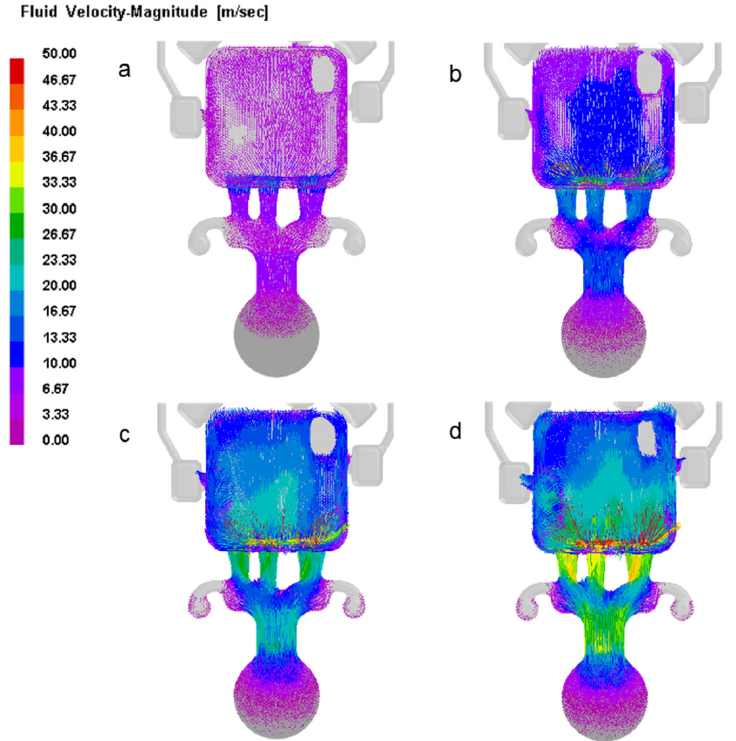
Figure 7. Simulation results of a fluid vector at the ingate and the cavity during the fast stage of piston velocity: ( a ) piston velocity was 0.8 m/s, ( b ) piston velocity was 1.6 m/s, ( c ) piston velocity was 2.4 m/s and ( d ) piston velocity was 3.2 m/s.